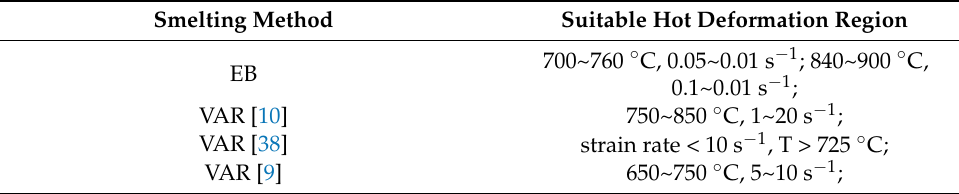
Table 4. Hot deformation of TA1 produced by EB and VAR. Smelting